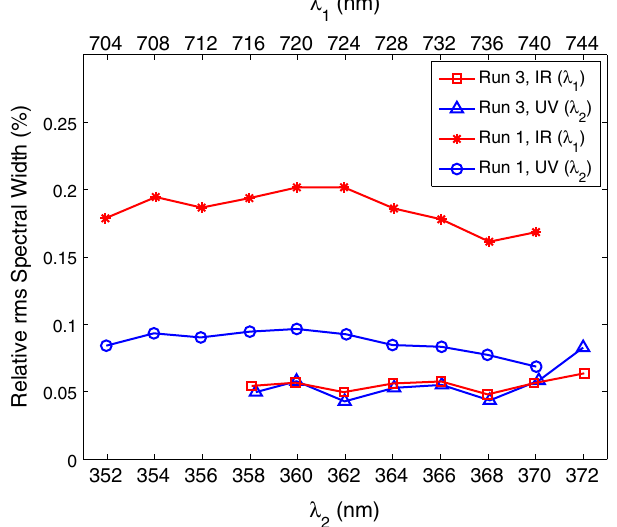
FIG. 5. Relative spectral widths (rms) in the wavelength tuning of the harmonic lasing in two runs, Run 1 and Run 3. Run 1 curves (starred and circled) represent the relative spectral widths in the measurement shown in Fig. 3 of Ref. [47]. In this measurement, the three-undulator configuration was used with loss curves L1 and beam current about 20 mA. Run 3 curves (squared and triangled) show the relative spectral widths in Fig. 4, where four undulators are used with loss curves L2, and the beam current is set to about 12